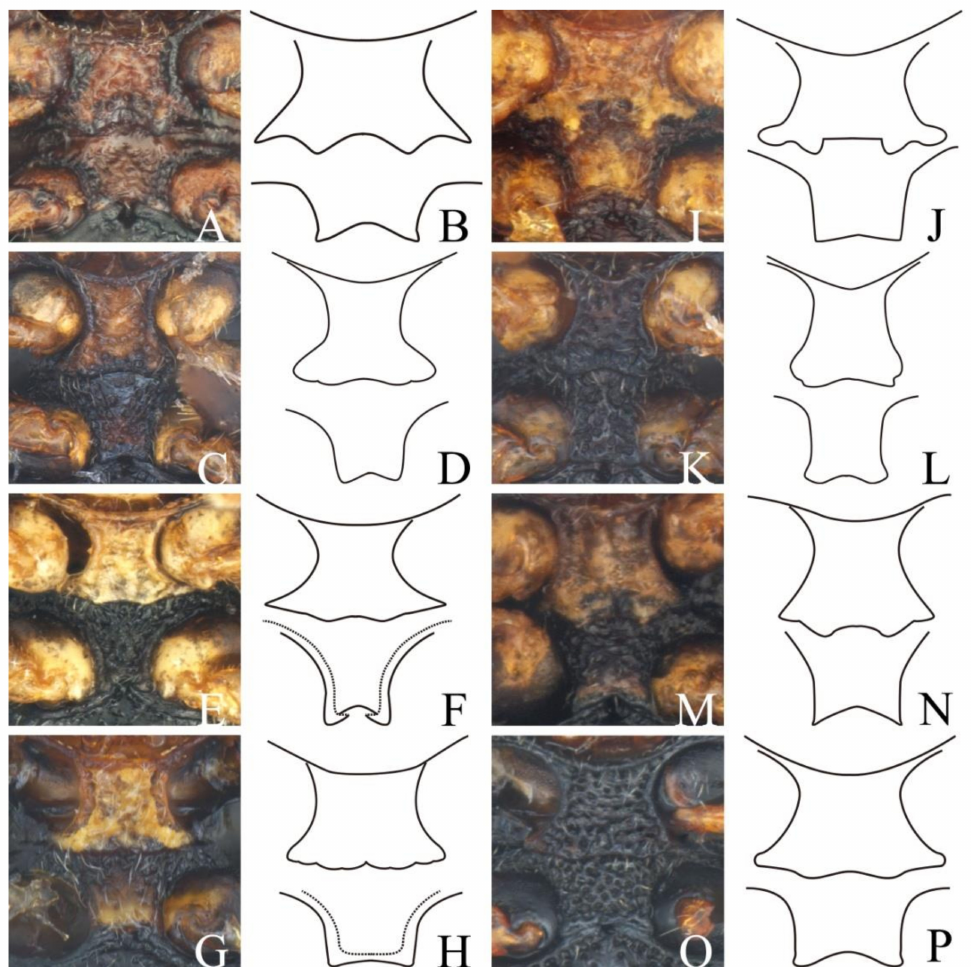
Figure 1. Cryptocephalus (Burlinius) prosternum and mesoventrite ( A , B ) C. ( Burlinius ) longchien- sis Duan & Zhou, sp. nov. ( C , D ) C. ( Burlinius ) baowenzhengi Duan & Zhou, sp. nov. ( E , F ) C. ( Burlinius ) tomurensis Duan & Zhou, sp. nov. ( G , H ) C. ( Burlinius ) bilineatus ( I , J ) C. ( Burlinius ) ni- grofasciayus ( K , L ) C. ( Burlinius ) glabrelegantulus Duan & Zhou, sp. nov. ( M , N ) C. ( Burlinius ) nebulo ( O , P ) C. ( Burlinius ) yangweii